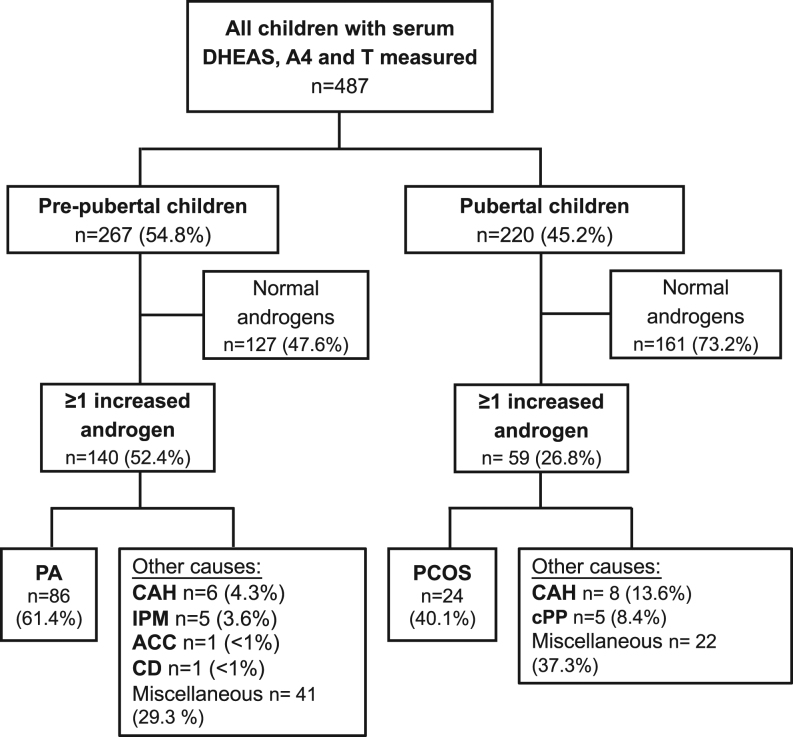
Flowchart of the distribution of diagnoses according to pre-pubertal vs post-pubertal status in 487 children who underwent simultaneous measurement of serum DHEAS, A4 and testosterone. ACC, adrenocortical carcinoma; CAH, congenital adrenal hyperplasia; CD, Cushing’s disease; cPP, central precocious puberty; IPM, isolated premature menarche; PA, premature adrenarche; PCOS, polycystic ovary syndrome.